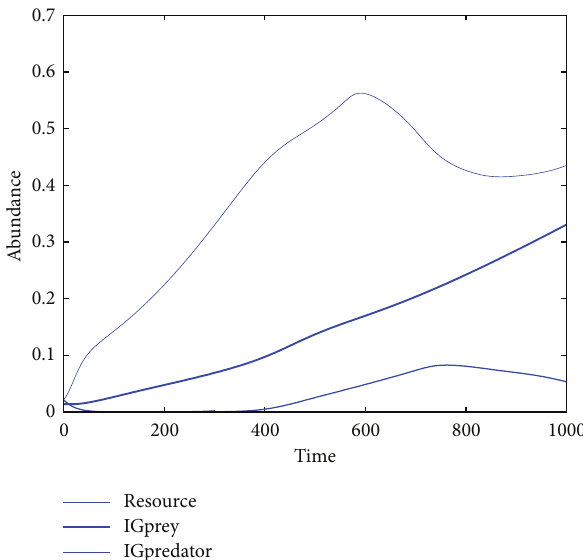
Figure 6: The population dynamics of the IGP system with diffusion. All parameter values are the same as Figure